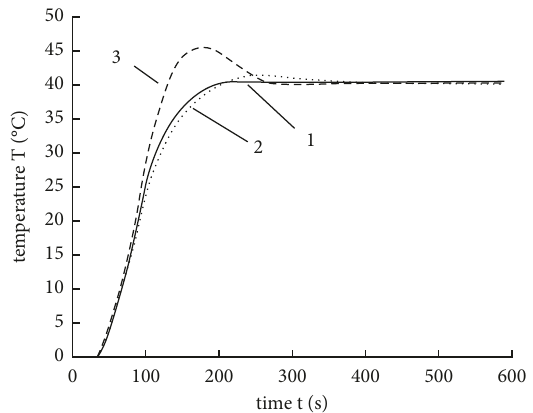
Figure 6: Experimental results of temperature control